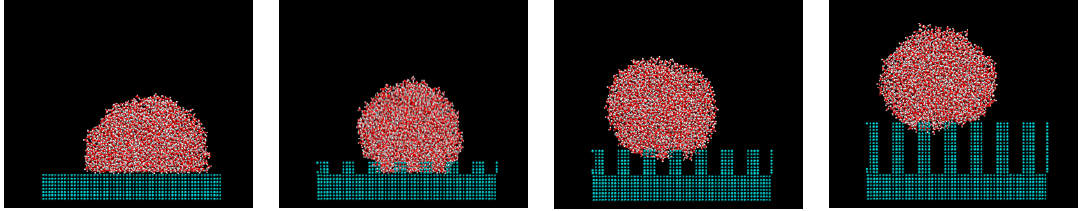
Figure 8. Droplets on nanostructures with ε = 0.9869 kJ/mol.